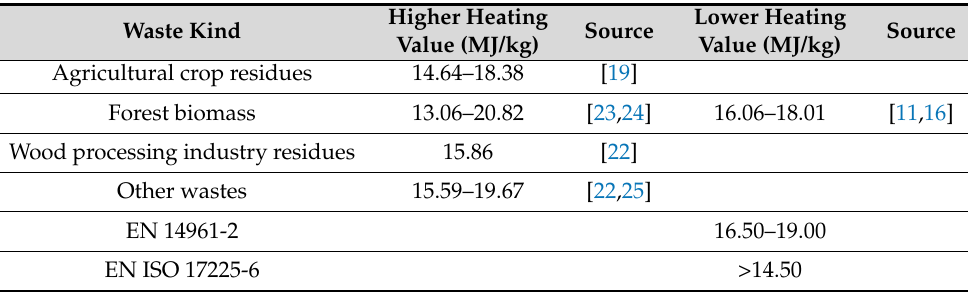
Table 1. Heating values of different wastes’ constituents of non-conventional fuels and EN 14961-2 and EN ISO 17225-6 Standard heating